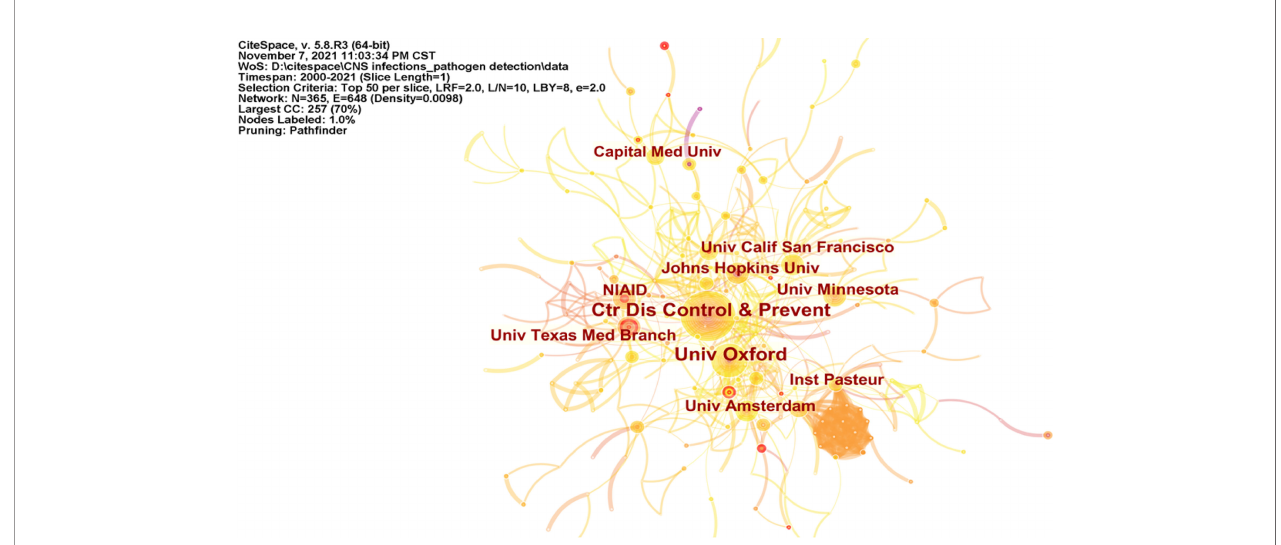
FIGURE 8 | Visualization map of the scienti fi c collaboration network analysis among